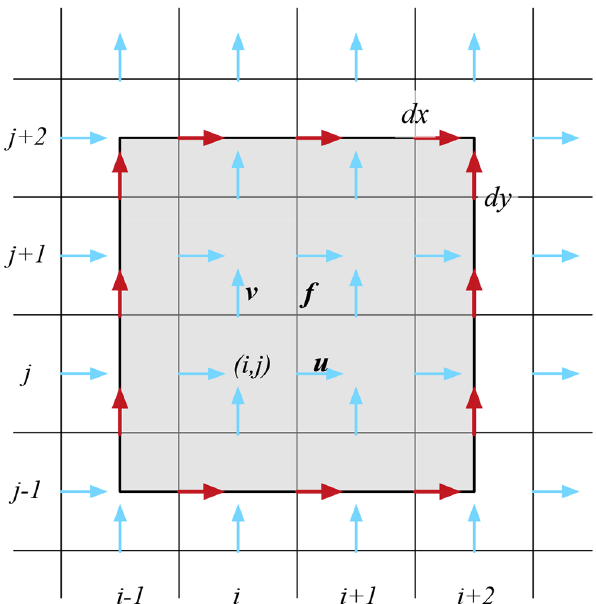
Figure B1. Spatial scaling of 3 × 3 cells with Arakawa-C grid stag- gering. All velocities used during the computation of line integrals are marked by red arrows, with others marked by